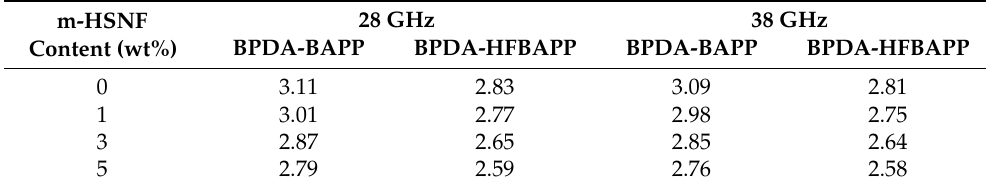
Table 4. Dielectric constant of polyimide/m-HSNF composites at 28 and 38 GHz.